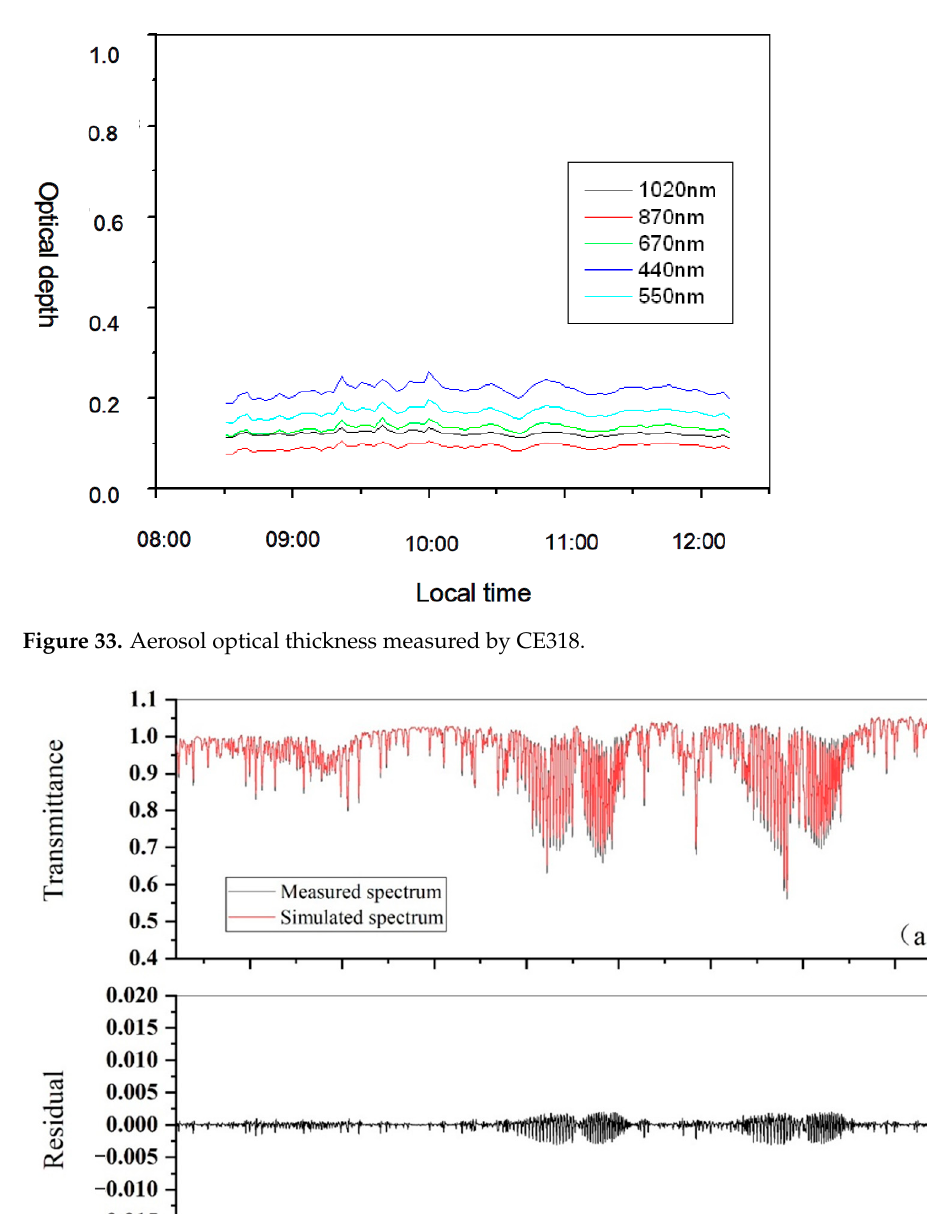
Figure 35. HRFTS and GMI inversion results. 6. Conclusions Due to the complexity of satellite remote sensing links for atmospheric composition, there are many difficulties and uncertainties in data processing and composition retrieval.